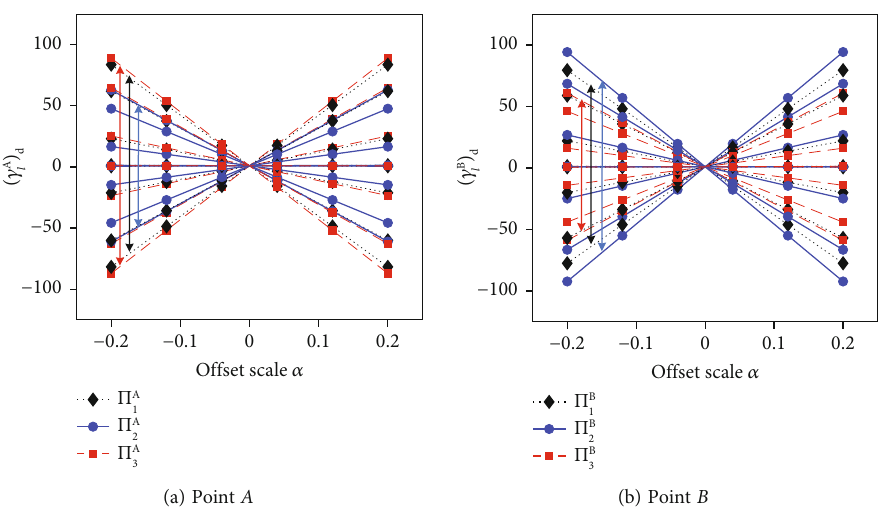
Þ ð γ B Þ ff erent o ff set scale. l l d and d with di